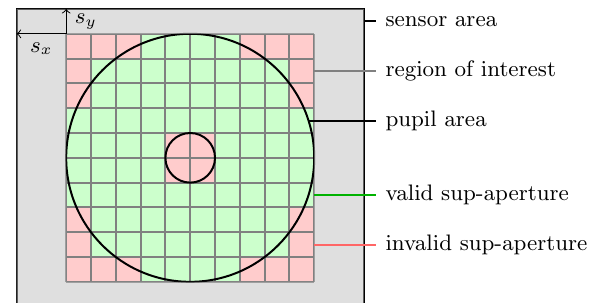
Figure 6. Illustration of various regions on the sensor area. The gray area is the sensor area on which the stream-based CoG operates. The region of interest is selected such that it covers the pupil of the imaging system. The green segments indicate those valid MLA lenslets within the pupil, while the red segments are invalid sub-apertures for wavefront reconstruction.